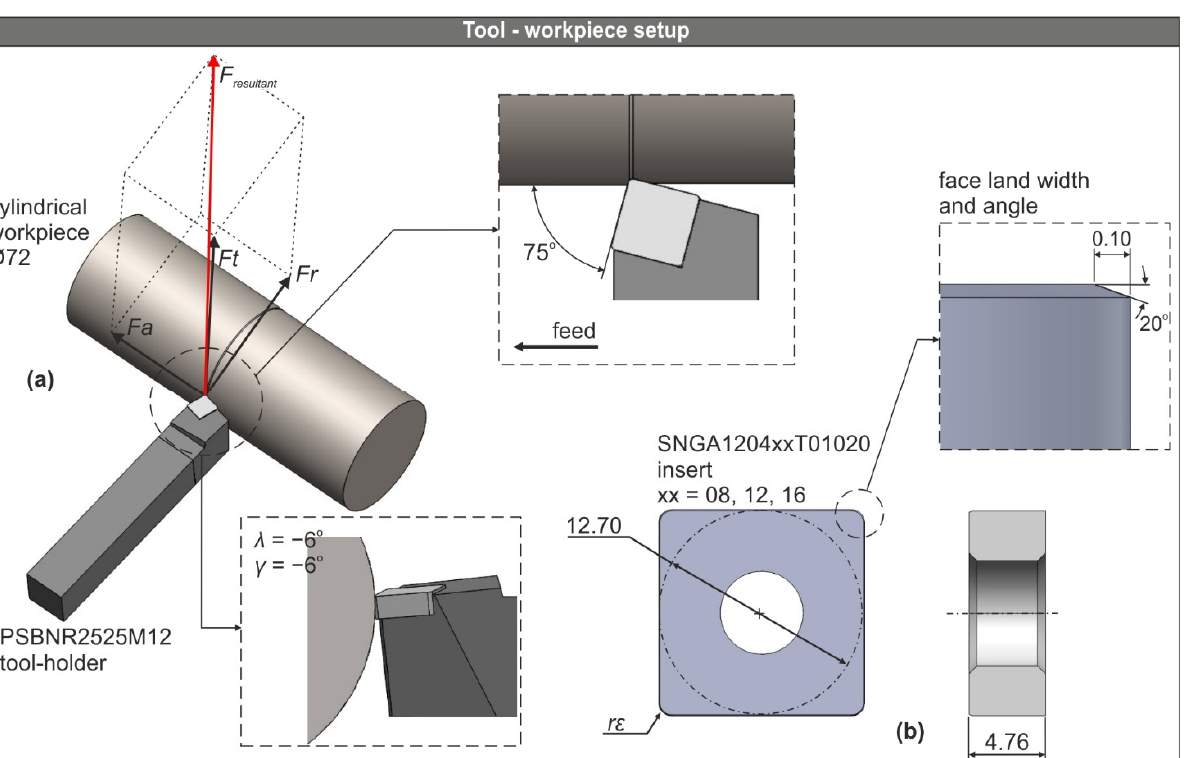
Figure 1. ( a ) The CAD-based setup of the tool-workpiece assembly and ( b ) the geometry of the turning insert.